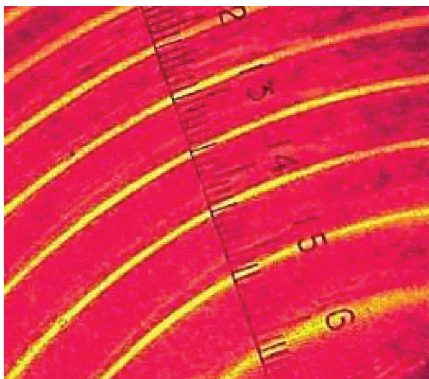
Figure 7: Photograph showing some interference fringes given by a F - P interferometer. A reticle was overlapped with the fringes. Minimum distance in the reticle was 0.1mm.